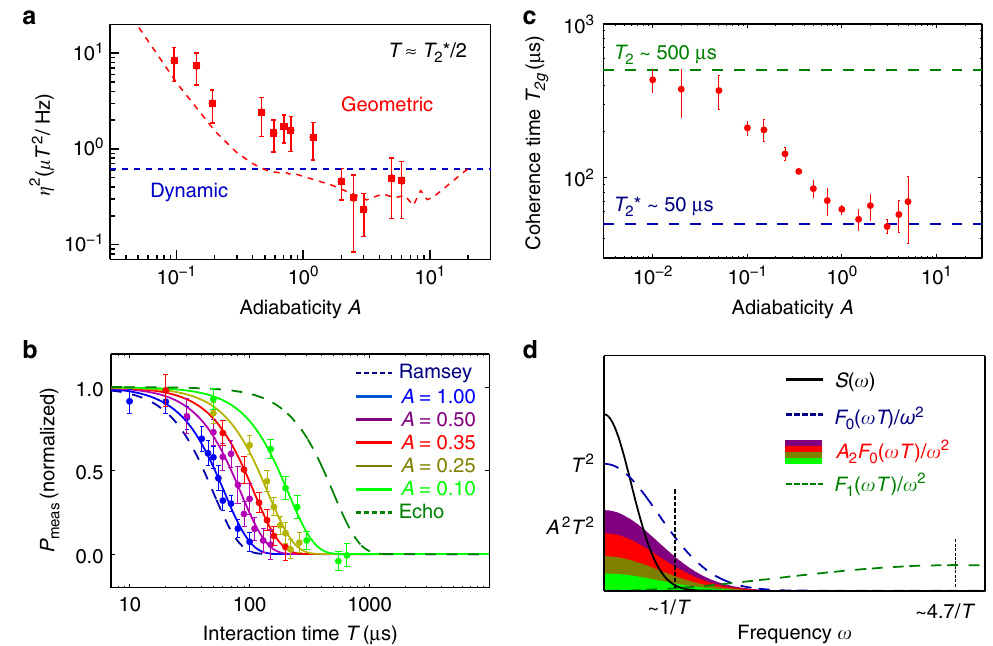
Fig. 4 Improved geometric-phase coherence time and sensitivity in nonadiabatic regime. a Measured geometric-phase magnetic fi eld sensitivity-squared (red squares) plotted against adiabaticity parameter A using a fi xed interaction time of T (cid:5) T 2 */2 at which the dynamic-phase Ramsey sequence gives optimal sensitivity (dashed blue line). Dashed red line shows geometric-phase sensitivity lower limit calculated by a numerical simulation assuming maximum signal contrast. The simulation does not include the contrast reduction due to hyper fi ne modulation. b Measured Berry sequence signal as a function of interaction time T for various adiabaticity parameter values. Color dots are data; solid color lines are exponential fi ts to data ~exp( T / T 2g ) 2 . Blue and green dashed lines indicate T 2 * and T 2 decay of the dynamic-phase signal measured with a Ramsey and Hahn-echo sequence, respectively. c Measured geometric-phase coherence time T 2g as a function of adiabaticity parameter A . Three regimes are observed: (i) For A < 0.1, T 2g ~ T 2 , (ii) For 0.1 < A < 1.0, T 2g ~ T 2 */ A , and (iii) For A ~ 1.0, T 2g ~ T 2 *. d Qualitative representation of contributions to the decoherence function (Eq. (3)) in the frequency domain: environmental noise spectral density function S ( ω ) (black line); dynamic-phase (spin-echo) fi lter function F 1 ( ω T )/ ω 2 (dashed green line); and geometric- phase (Berry sequence) fi lter function A 2 F 0 ( ω T )/ ω 2 ( fi lled color area, same color-coding as in b ), which vanishes in the limit A → 0 and reaches the Ramsey sequence function F 0 ( ω T )/ ω 2 (dashed blue line) in the limit A → 1. Error bars represent one standard deviation of the